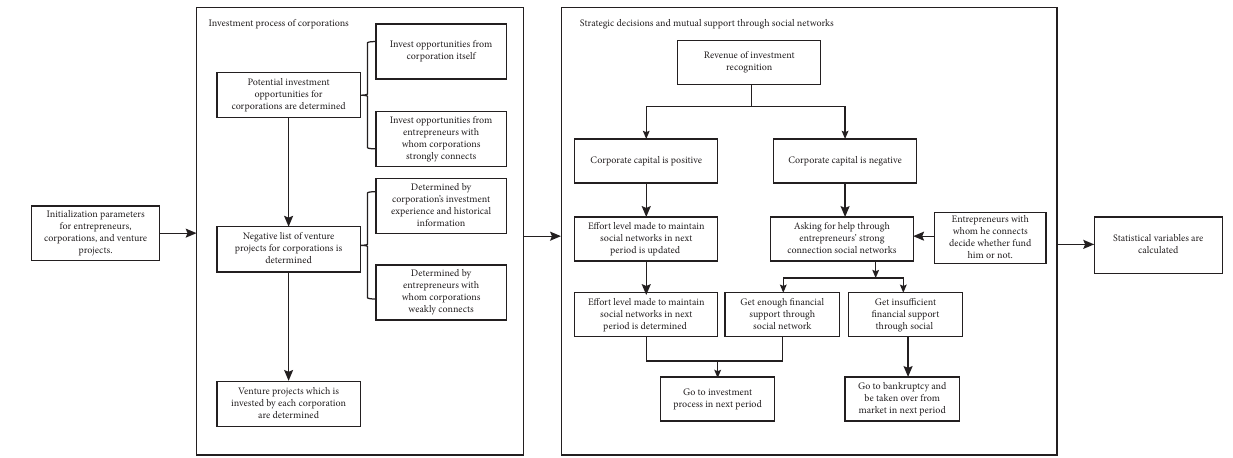
Figure 2: Process of